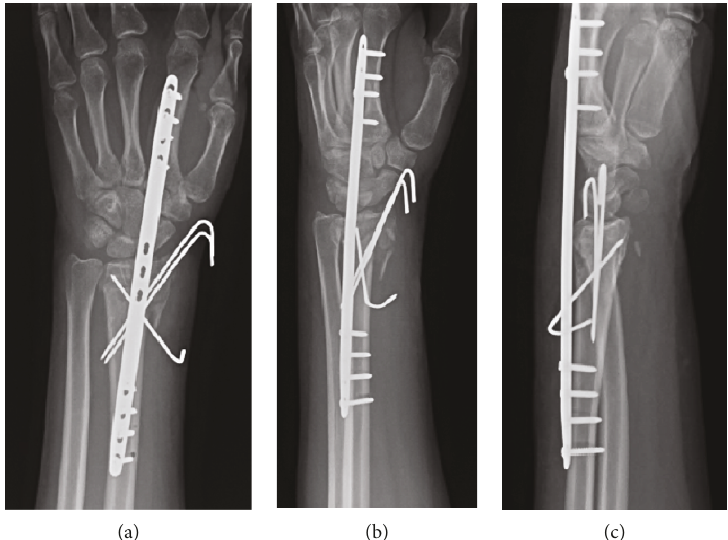
Figure 2: Initial fi xation. Postoperative X-ray showing fi xation with a 2.4/2.7 mm Synthes dorsal spanning plate and three K